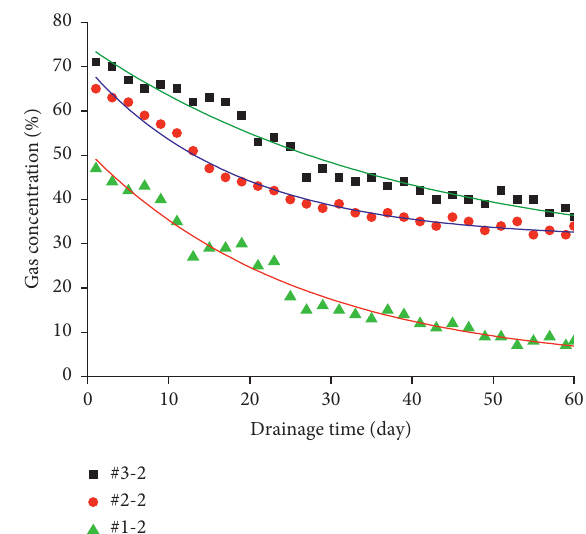
Figure 17: Curves of gas concentration in boreholes at monitor line